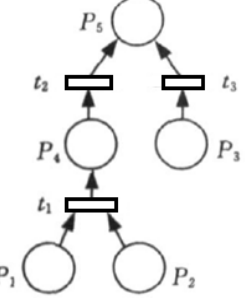
Figure 10. Petri Net